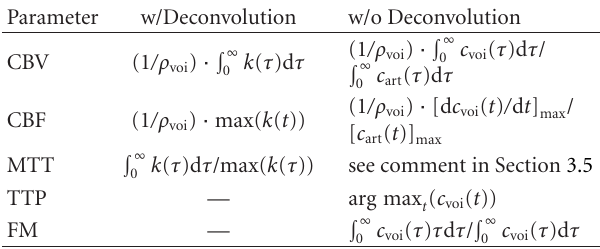
Table 2: Summary of perfusion parameters and how these param- eters can be estimated using deconvolution-based and nondecon- volution-based